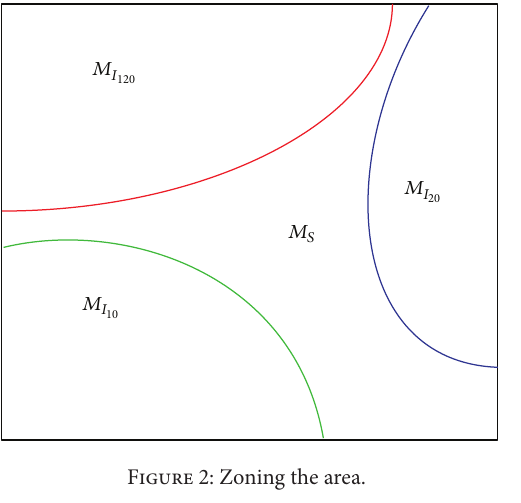
Figure 2: Zoning the